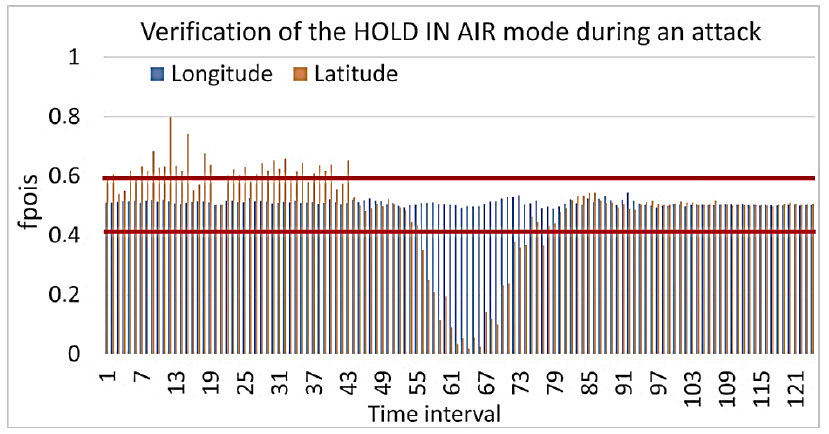
Figure 6. Verification of the HOLD IN AIR mode calculation of the cumulative function for the Poisson distribution during a